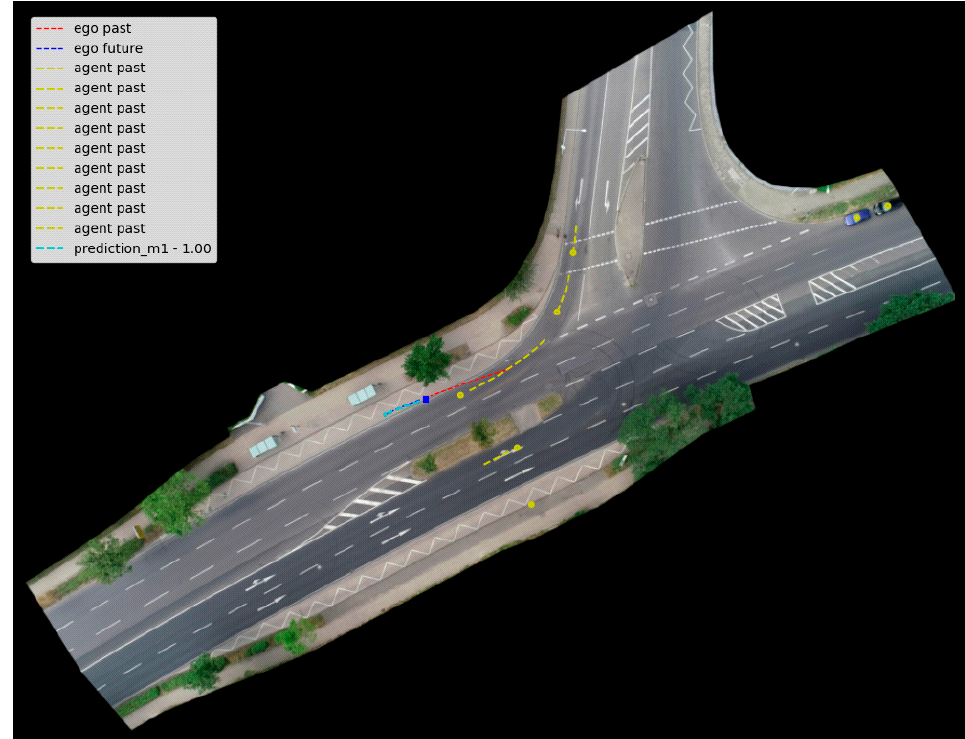
Figure 13. Traffic scene prediction with the unimodal approach. In this scenario, the bus is stopping at the bus station.